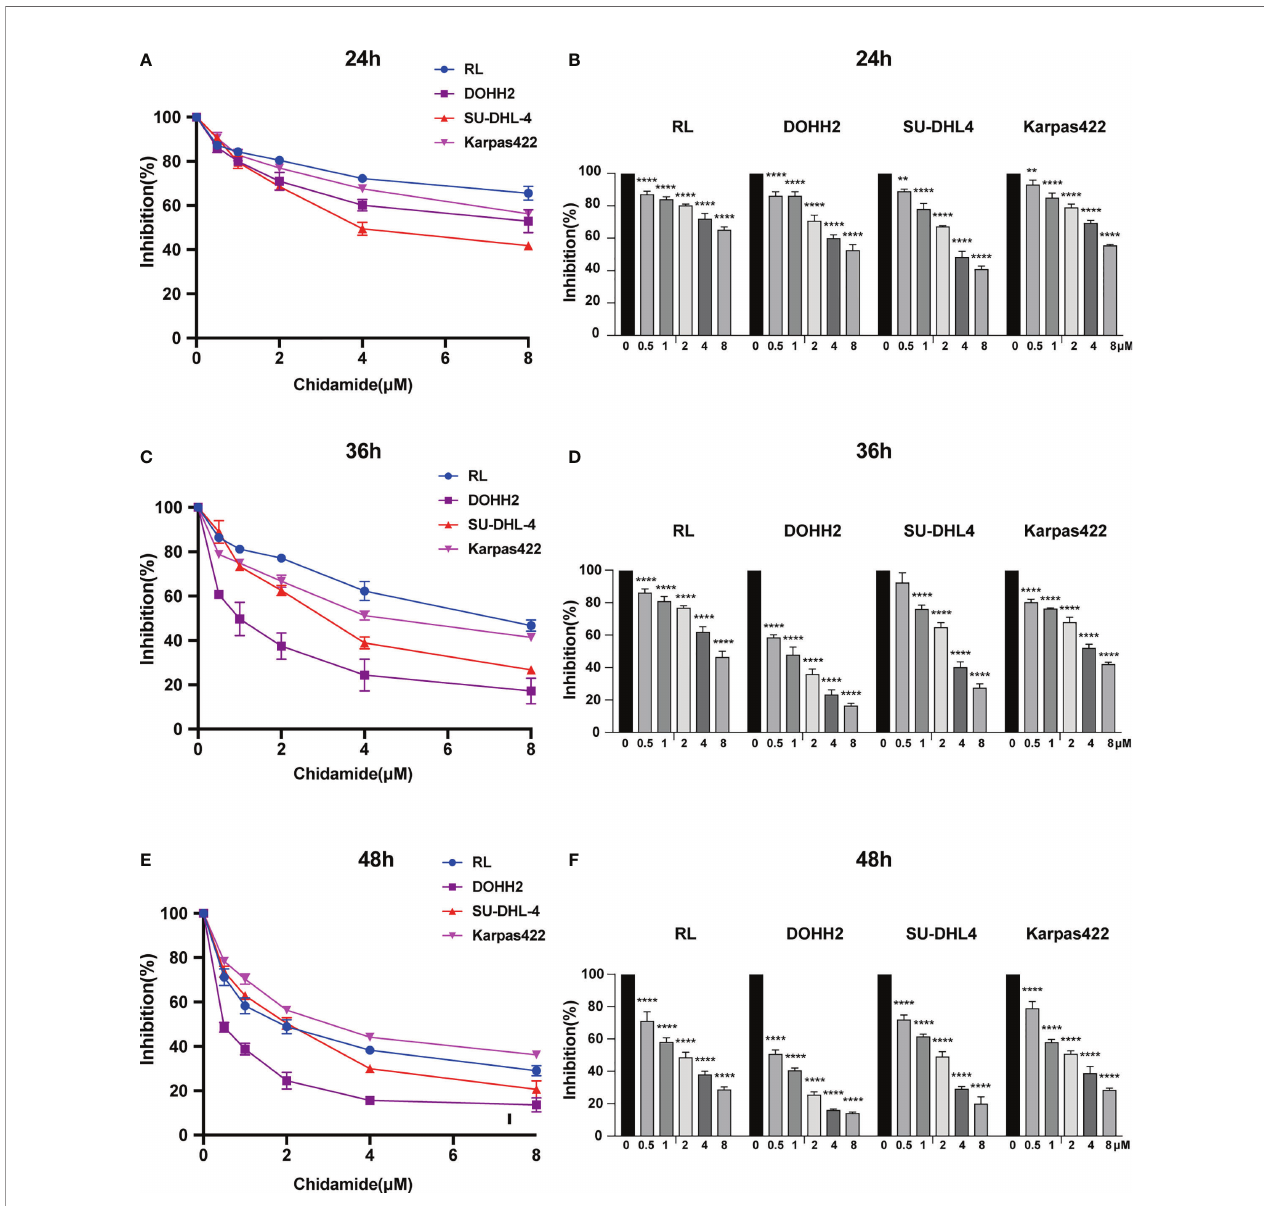
FIGURE 1 | Chidamide inhibits viability in FL cell lines. Human FL RL, DOHH2, SU-DHL4 and Karpas422 cells were exposed to the indicated concentrations of chidamide for (A) 24 h, (C) 36 h or (E) 48 h, after which cell proliferation was measured by the CCK-8 assay. Data (mean ± S.D.) from at least three independent experiments are shown in (B) 24 h, (D) 36 h and (F) 48 h. (** p < 0.01; **** p <